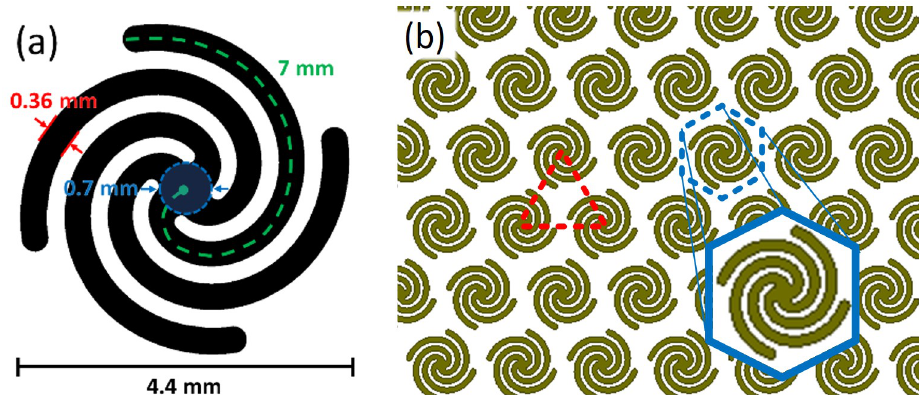
Figure 1. Spiral-based frequency selective surface (FSS) design with triangular packing. Schematic of ( a ) Archimedean spiral dimensions, ( b ) triangular lattice of spirals including unit cell for periodic simulation (blue).